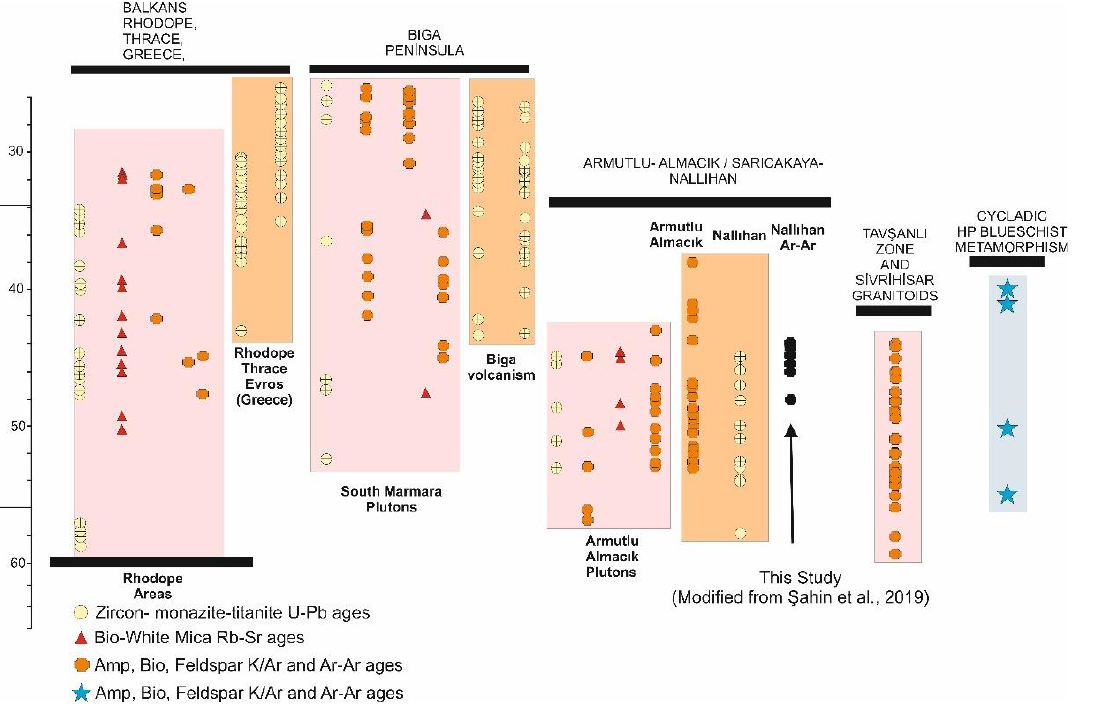
Figure 15. Age compilation of the magmatic and HP metamorphic events that shaped the Balkanatolia Magmatic Realm. Figure implemented from the study of Ersoy et al. [7]. Data compiled from